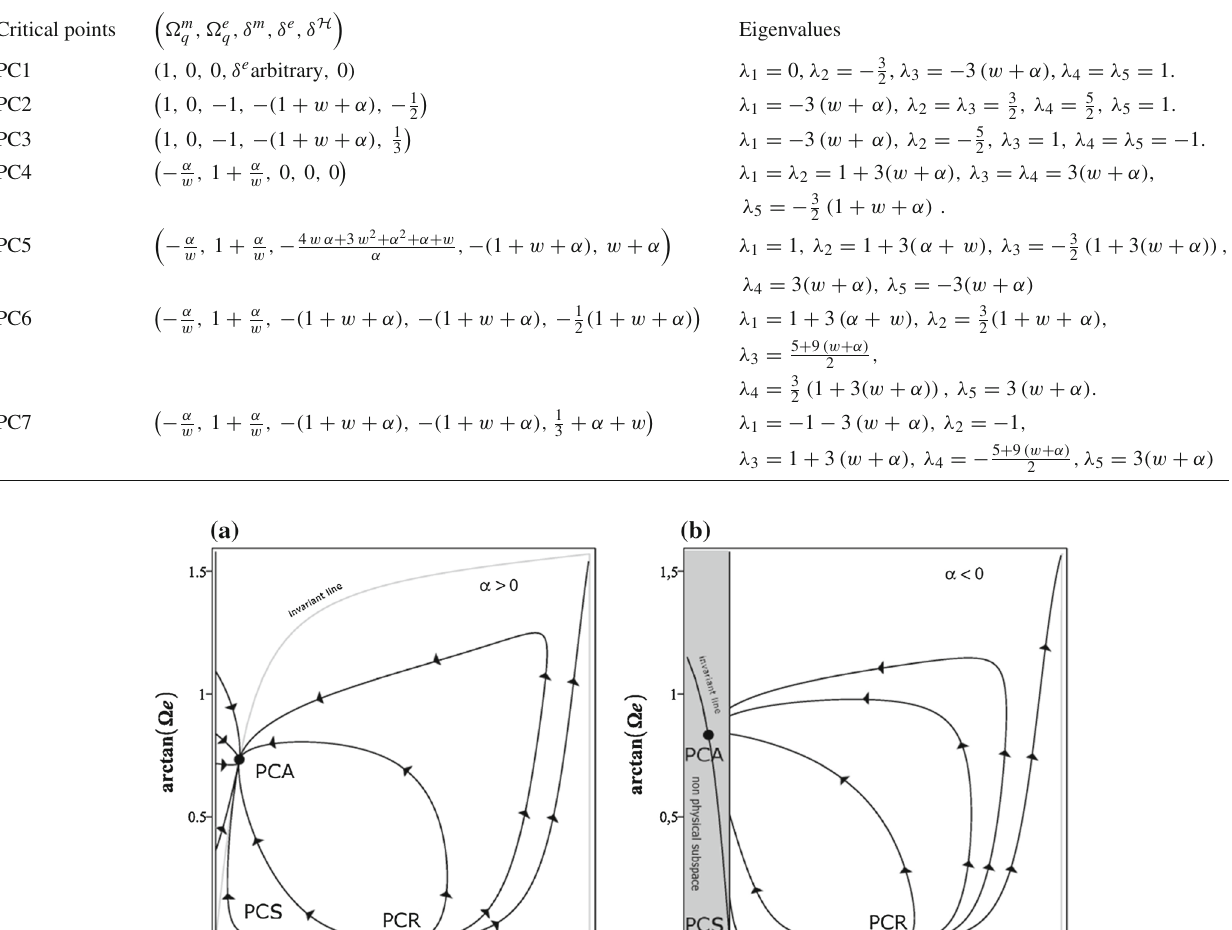
Table 1 The critical points and their respective eigenvalues of the system (20a–20e)